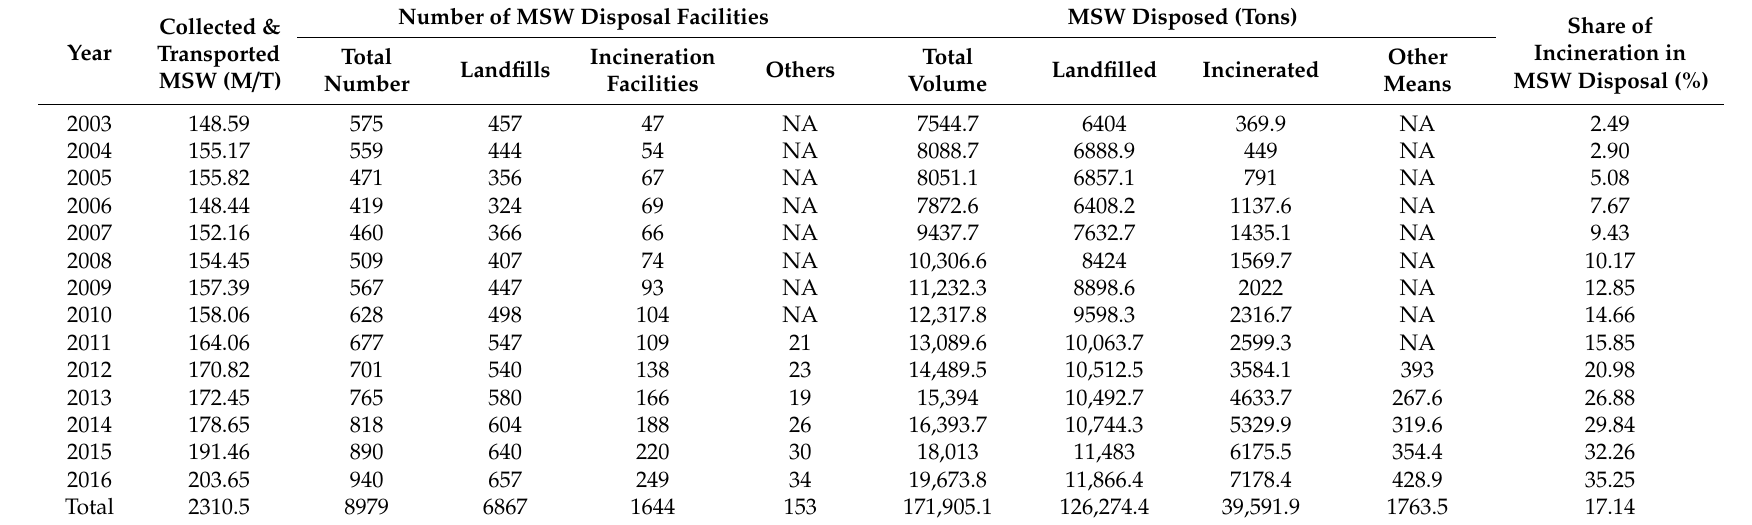
Table 1. MSW generation and disposal in China between 2003 and 2016 (data from National Bureau of Statistics (NBS,